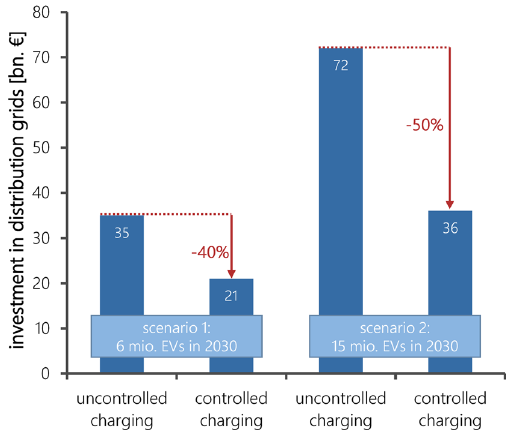
Fig. 1 Investments in distributions grids depending on electromobility ramp-up and control of charging processes (Agora Energiewende